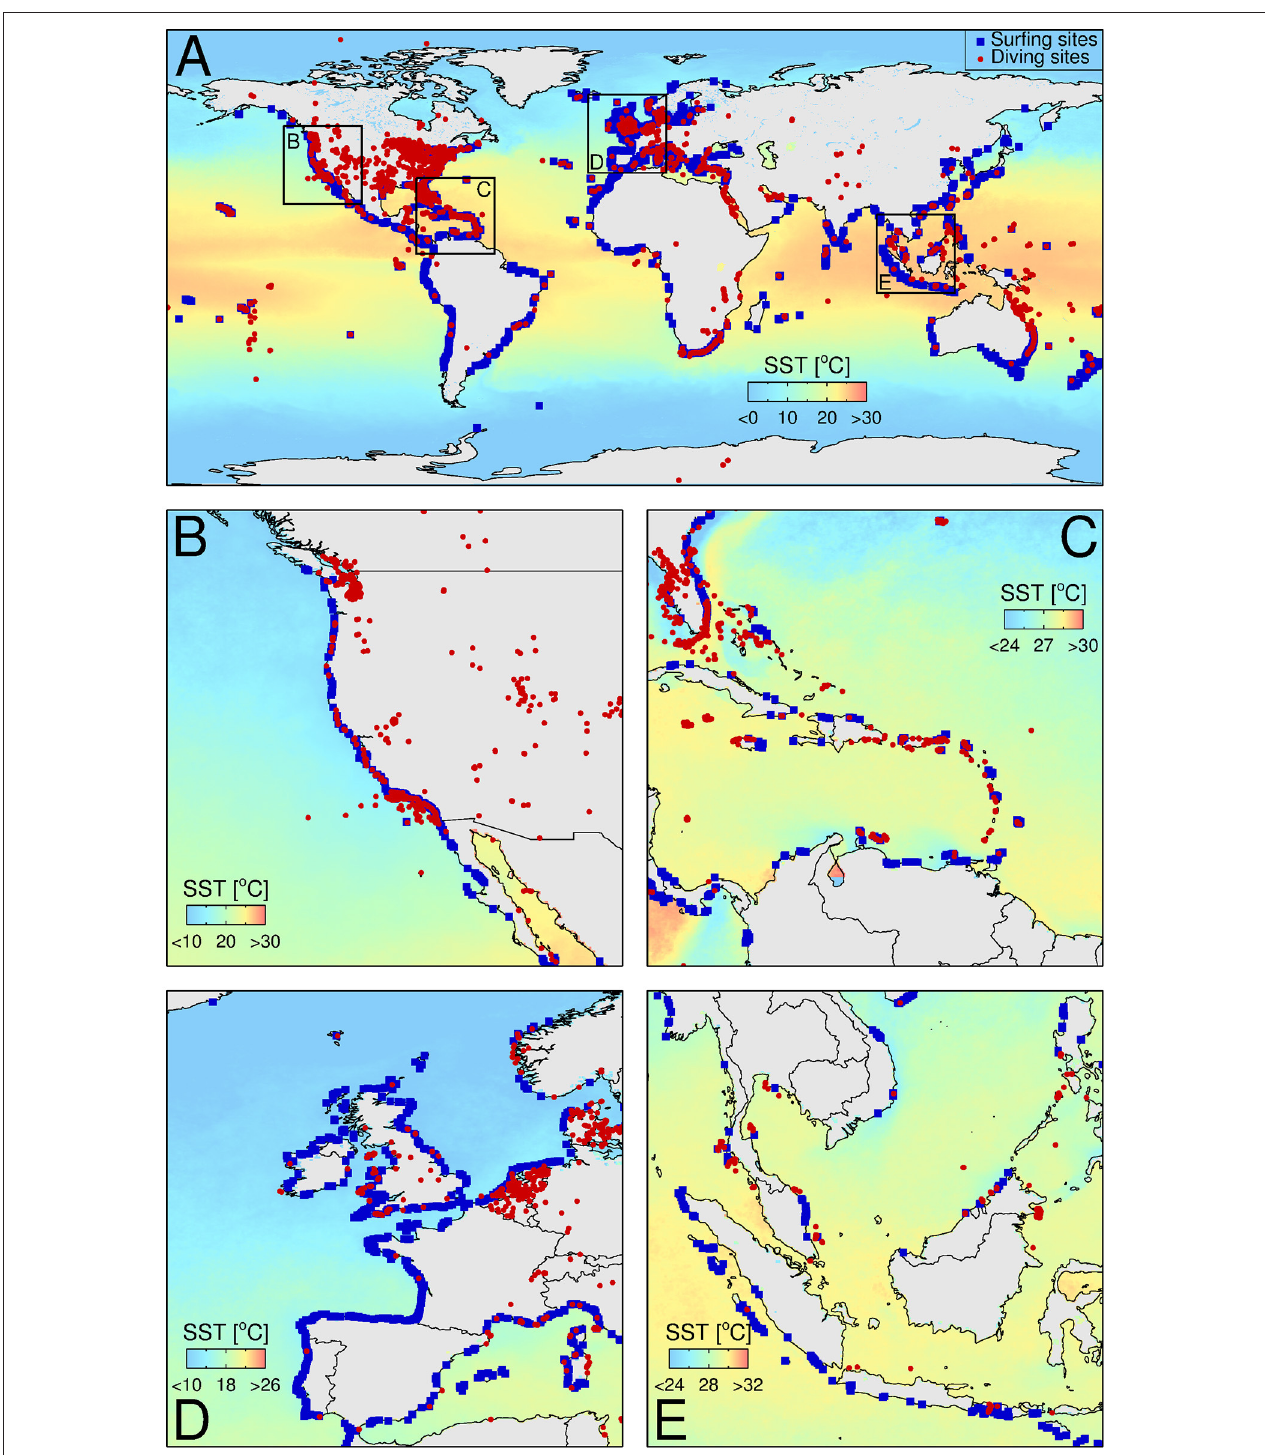
FIGURE 1 | Locations of surfing and dive sites around the globe. Positions were extracted from a wave prediction website (http://magicseaweed.com/) and from an open database of dive sites (http://www.divesites.com/) on the 18th July 2017. Panel (A) shows locations over the global ocean, (B) focusing on the west coast of North America, (C) the Caribbean, (D) western Europe and (E) Southeast Asia. Background image is an annual sea surface temperature (SST) composite for the year 2016 from the NASA MODIS-Aqua sensor (NASA, 2014). Note that the color scales varies between sub-figures.